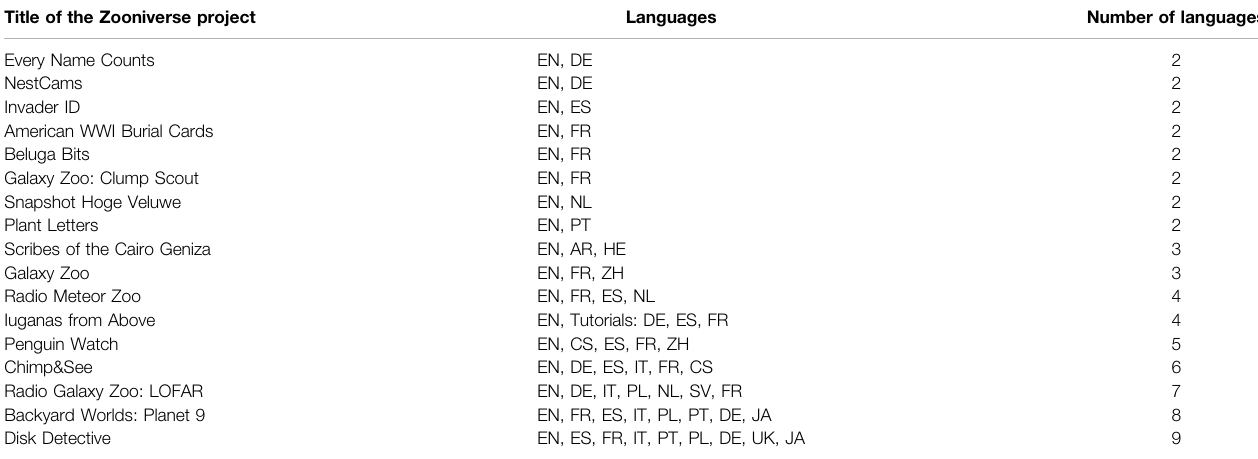
TABLE 2 | Zooniverse project pages available in at least two